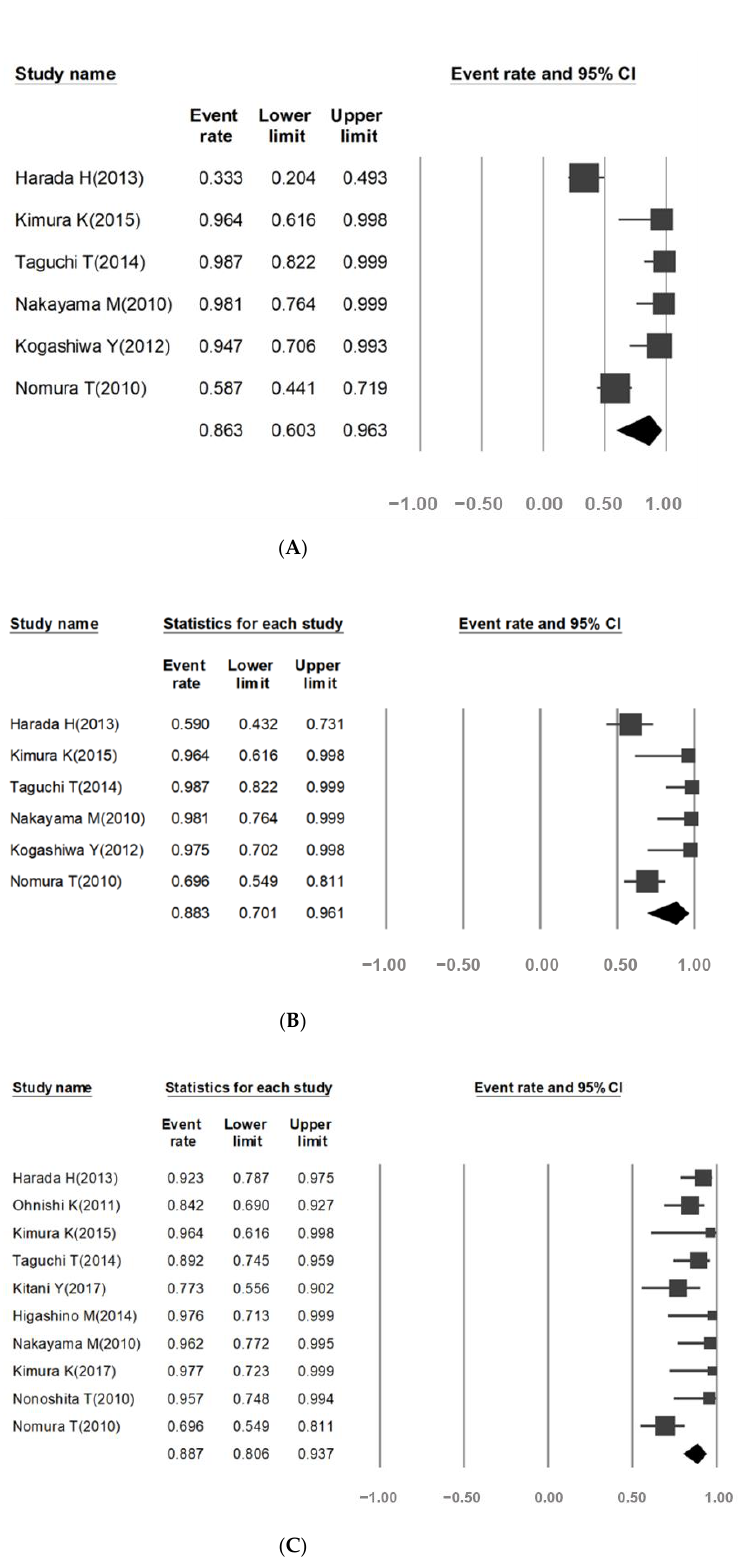
Figure 2. Objective response ( A ), Clinical benefit ( B ) and 3-year local control rate ( C ) of S-1 combined with radiotherapy for Non-nasopharyngeal head and neck cancer. Objective response: Complete Response +Partial Response; Clinical benefit: Complete Response +Partial Response + Stable Disease ≥24 weeks.